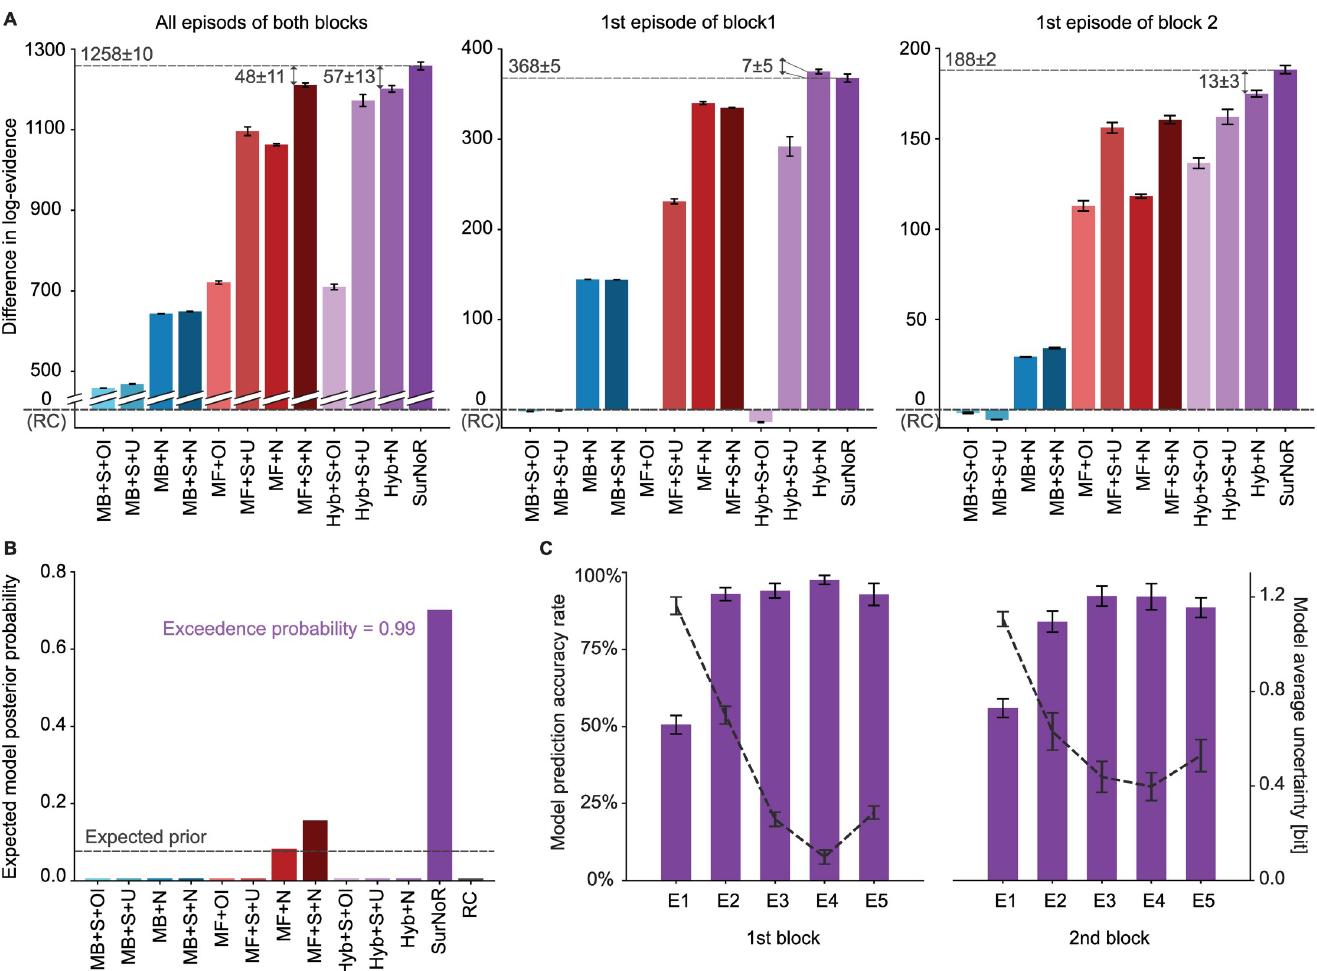
Fig 5. Model comparison of model-based (MB, blue bars), model-free (MF, red bars), and hybrid algorithms (Hyb and SurNoR, purple bars). Exploratory behavior is either induced by optimistic initialization (+OI), uncertainty-seeking (+U), unbiased random action choices (RC), or novelty-seeking (+N); e.g., a model- based algorithm with novelty seeking is denoted as MB+N. SurNoR and the model-free or hybrid algorithms annotated with ‘+S’ use surprise to modulate the learning rate of the model-free TD learner; SurNoR and all algorithms annotated with ‘+S’ use surprise modulation also during model building (see Methods). A . Difference in log-evidence (with respect to RC) for the algorithms for all episodes of both blocks (left panel), the 1st episode of block 1 (middle), and the 1st episode of block 2 (right panel). High values indicate good performance; differences greater than 3 or 10 are considered as significant or strongly significant, respectively (see Methods); a value of 0 corresponds to random action choices (RC). The random initialization of the parameter optimization procedure introduces a source of noise, and the small error bars indicate the standard error of the mean over different runs of optimization (Methods, statistical model analysis). B . The expected posterior model probability [52, 53] given the whole dataset (Methods) with random effects assumption on the models. C . Accuracy rate of actions predicted by SurNoR (left scale and purple bars: mean and the standard error of the mean across participant) and the average uncertainty of SurNoR (right scale and dashed grey curve: mean entropy of action choice probabilities and the standard error of the mean across